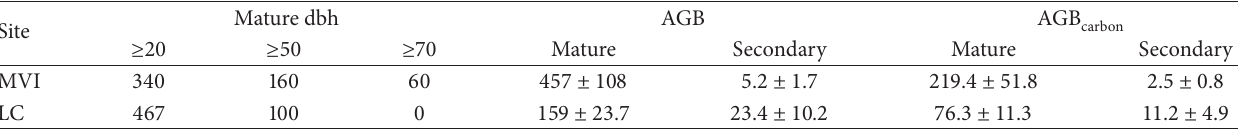
Table 1: Summarized data forAGB calculations forMonteverde Institute(MVI)and La Calandria(LC).Measurements ofstemdbh calculated as number of stems in size class per hectare. AGB for mature and secondary forest presented as oven-dried biomass calculated by equation of Brown [13] in units of metric tons (=Mg) per hectare (tha −1 ). AGB carbon is biomass carbon in tha −1